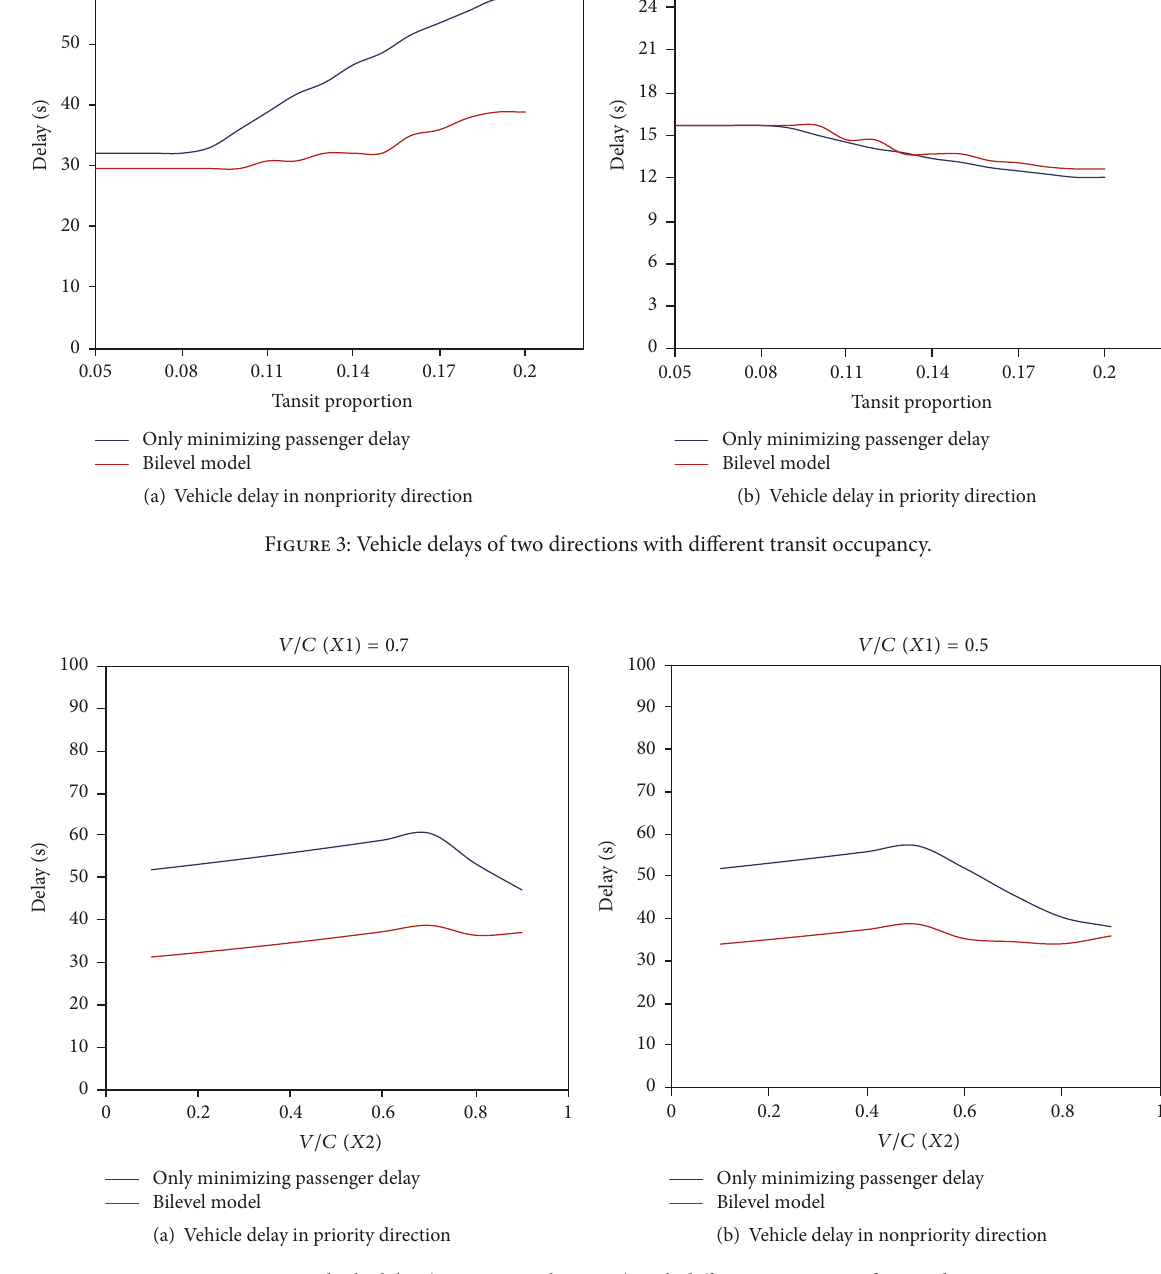
Figure 4: Vehicle delay (nonpriority direction) with different saturation of 𝑋2 and 𝑋1